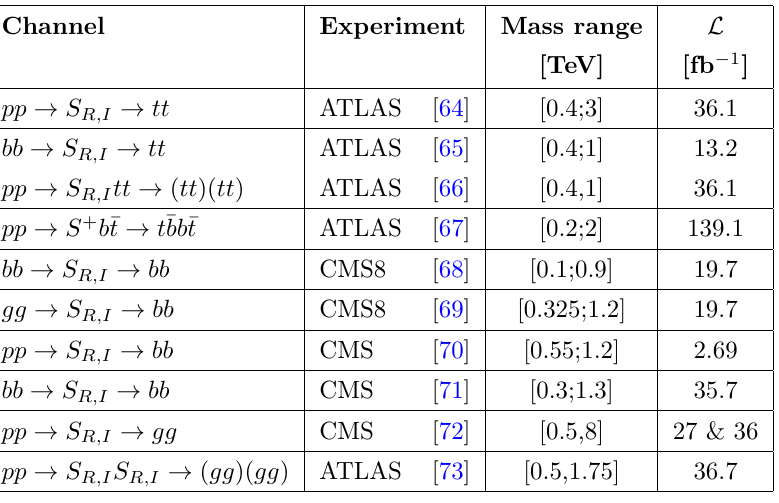
Table 3 . Data from direct searches included in the fit. CMS8 means CMS at 8 TeV, the rest is at 13